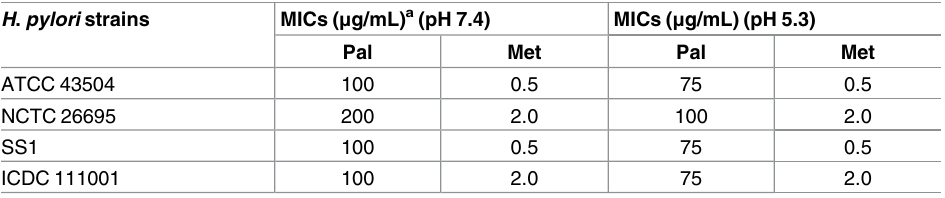
Table 1. Minimal inhibitory concentrations (MICs) of Pal and Met. H . pylori